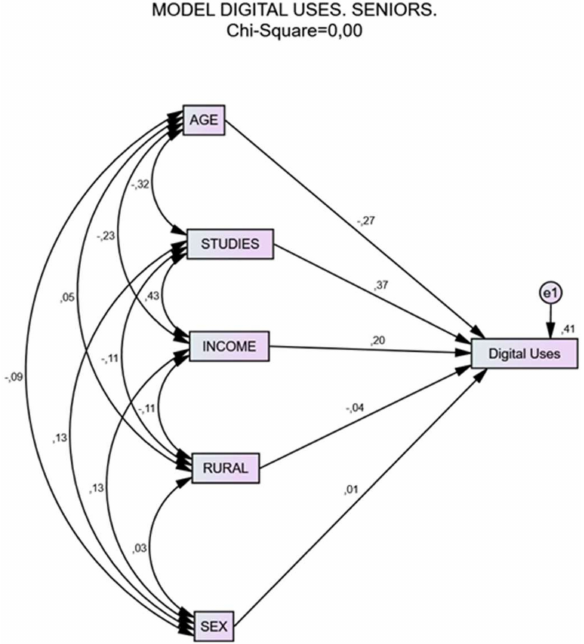
Figure 2. Digital Uses Senior Population